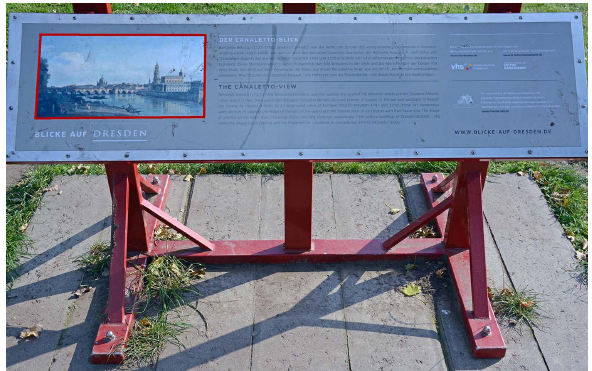
Figure 4. Arrangement of an observation point on northern bank of river with copy of 18th c. Dresden panorama painting by